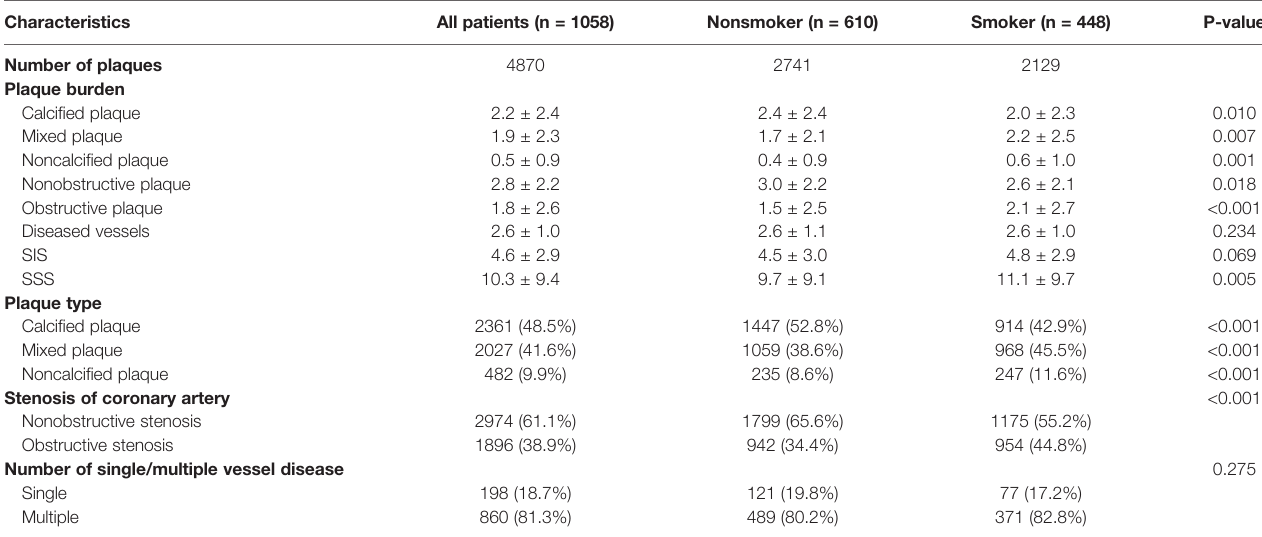
TABLE 2 | Characteristics of coronary artery plaque detected by CCTA in DM patients with and without a smoking history. Characteristics